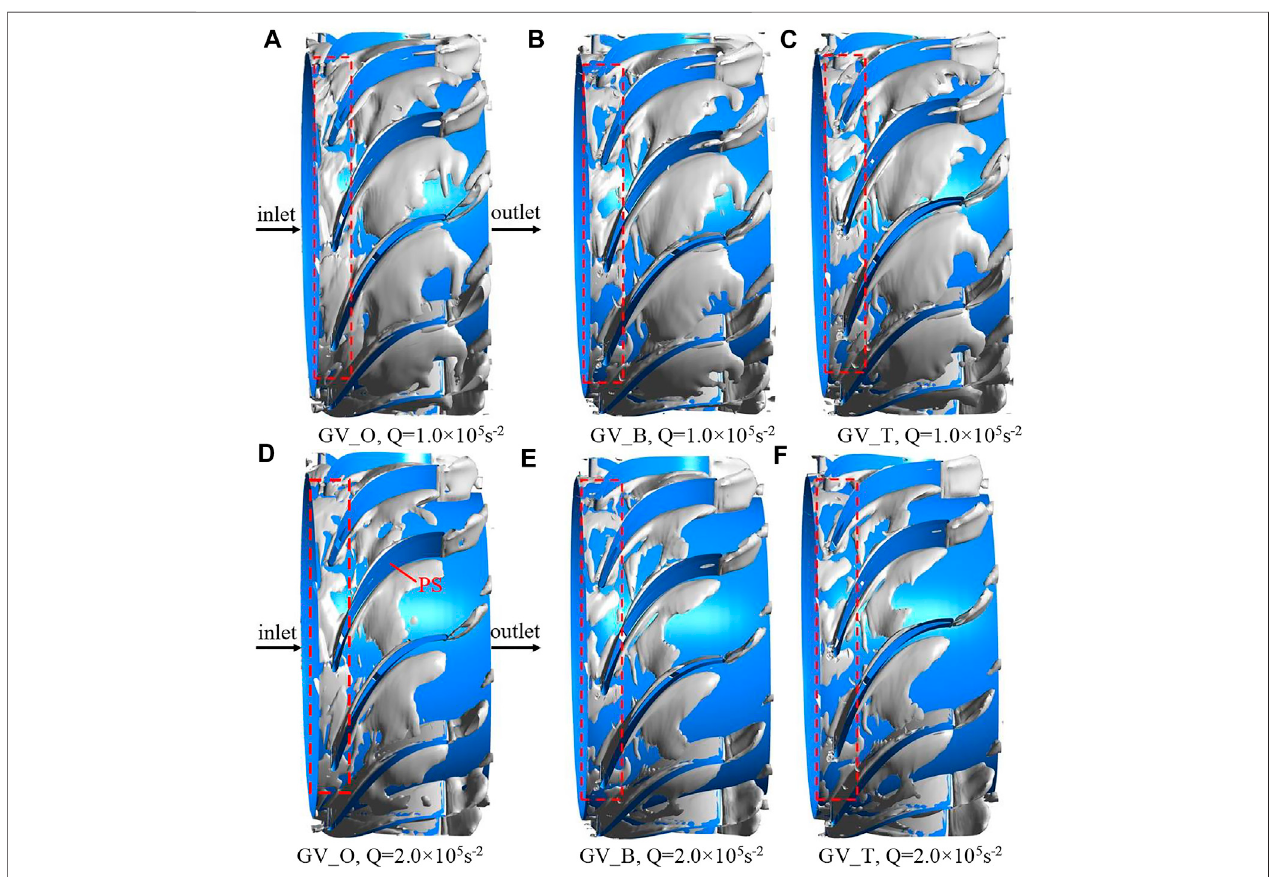
FIGURE19| Vortexstructureintheguidevane. (A) GV_O,Q=1.0×10 5 s − 2 . (B) GV_B,Q=1.0×10 5 s − 2 . (C) GV_T,Q=1.0×10 5 s − 2 . (D) GV_O,Q=2.0×10 5 s − 2 . (E) GV_B, Q = 2.0 × 10 5 s − 2 . (F) GV_T, Q = 2.0 × 10 5 s − 2